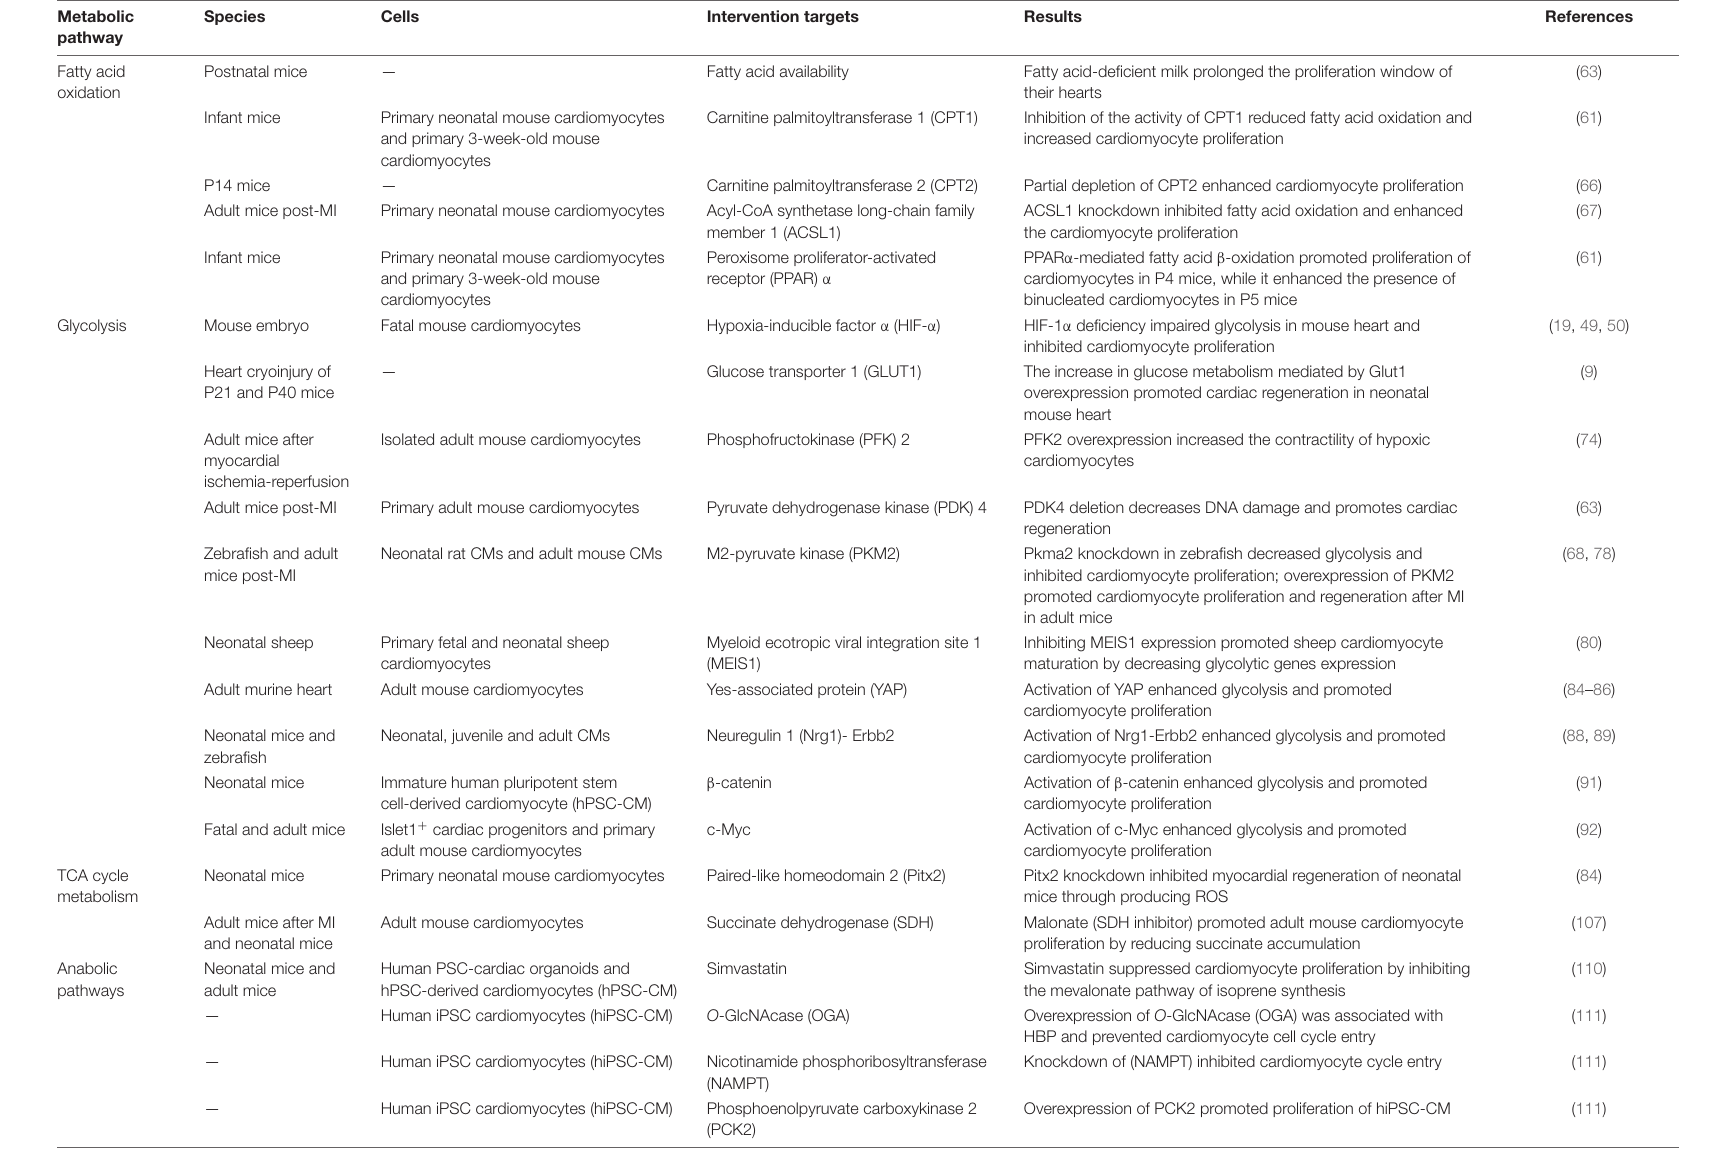
TABLE 1 | Summary of recent studies demonstrating the role of metabolism in heart regeneration. Metabolic pathway